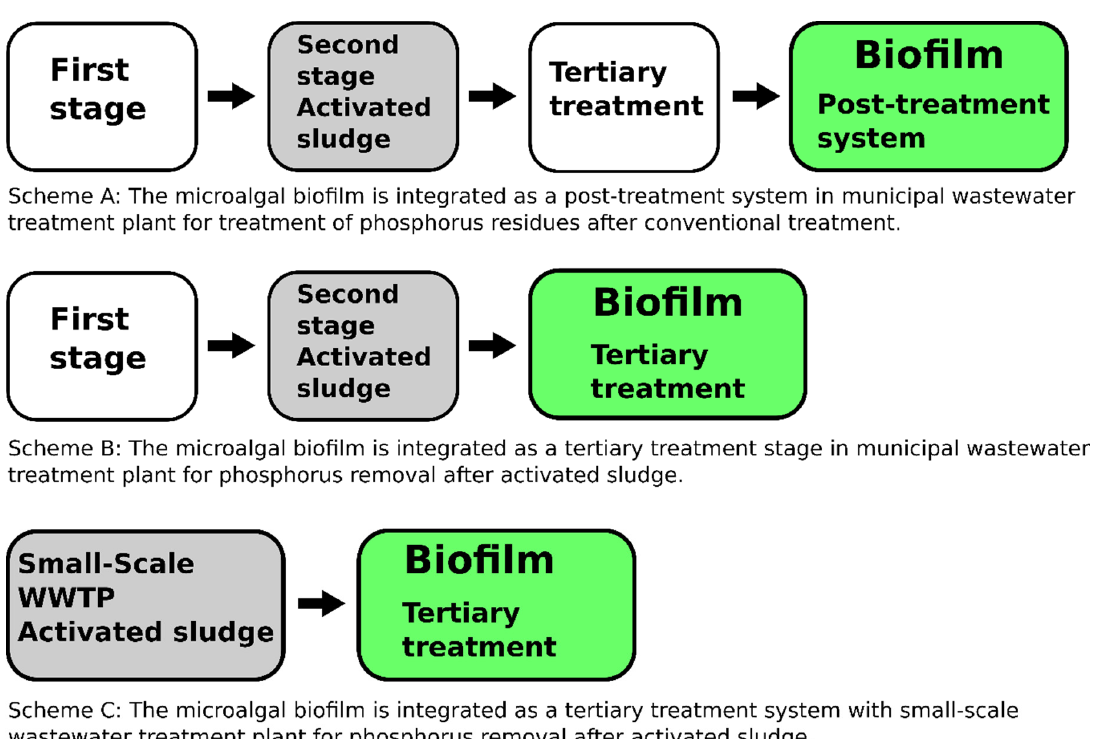
Figure 1. Designs for microalgal biofilm integration into conventional wastewater treatment systems.